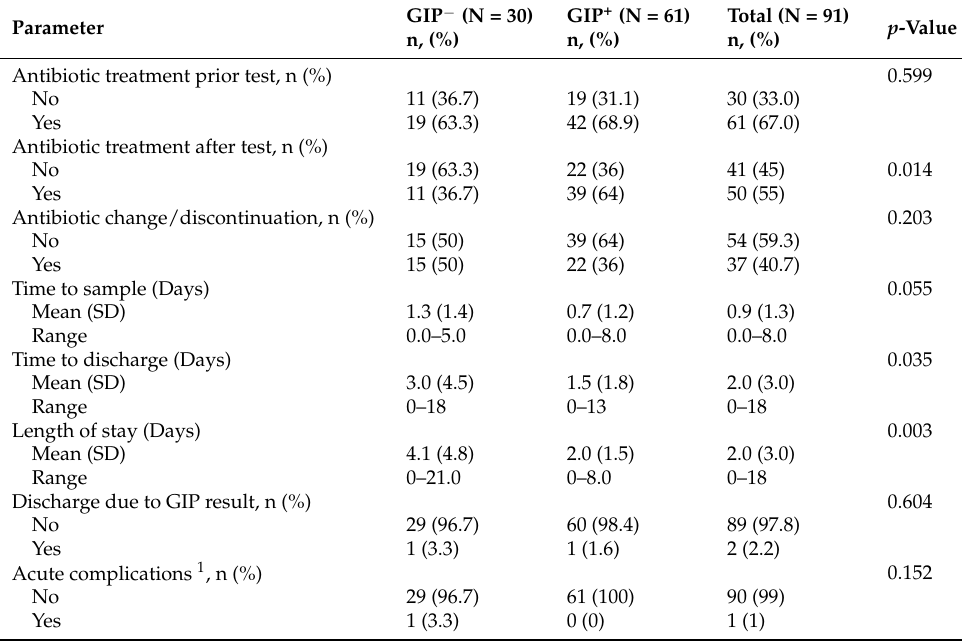
Table 2. Antibiotic status, length of stay and